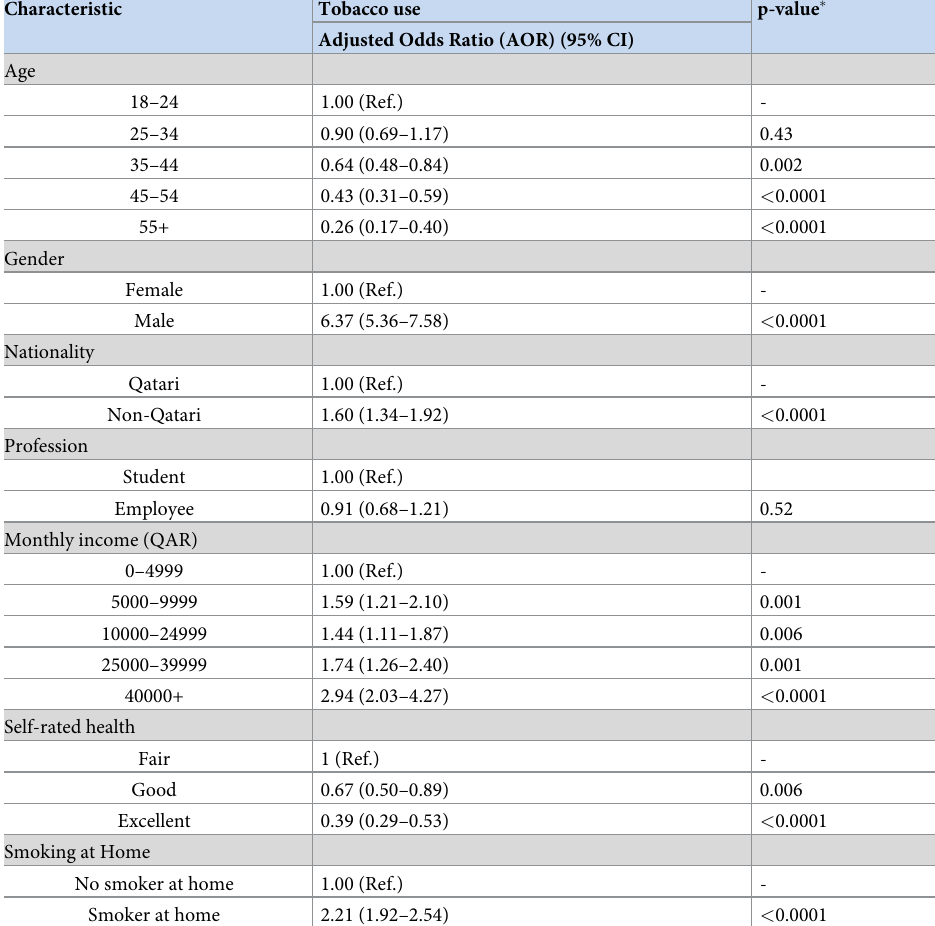
Table 5. Logistic regression for current tobacco users by participants’ characteristics for the total sample (N = 6904).